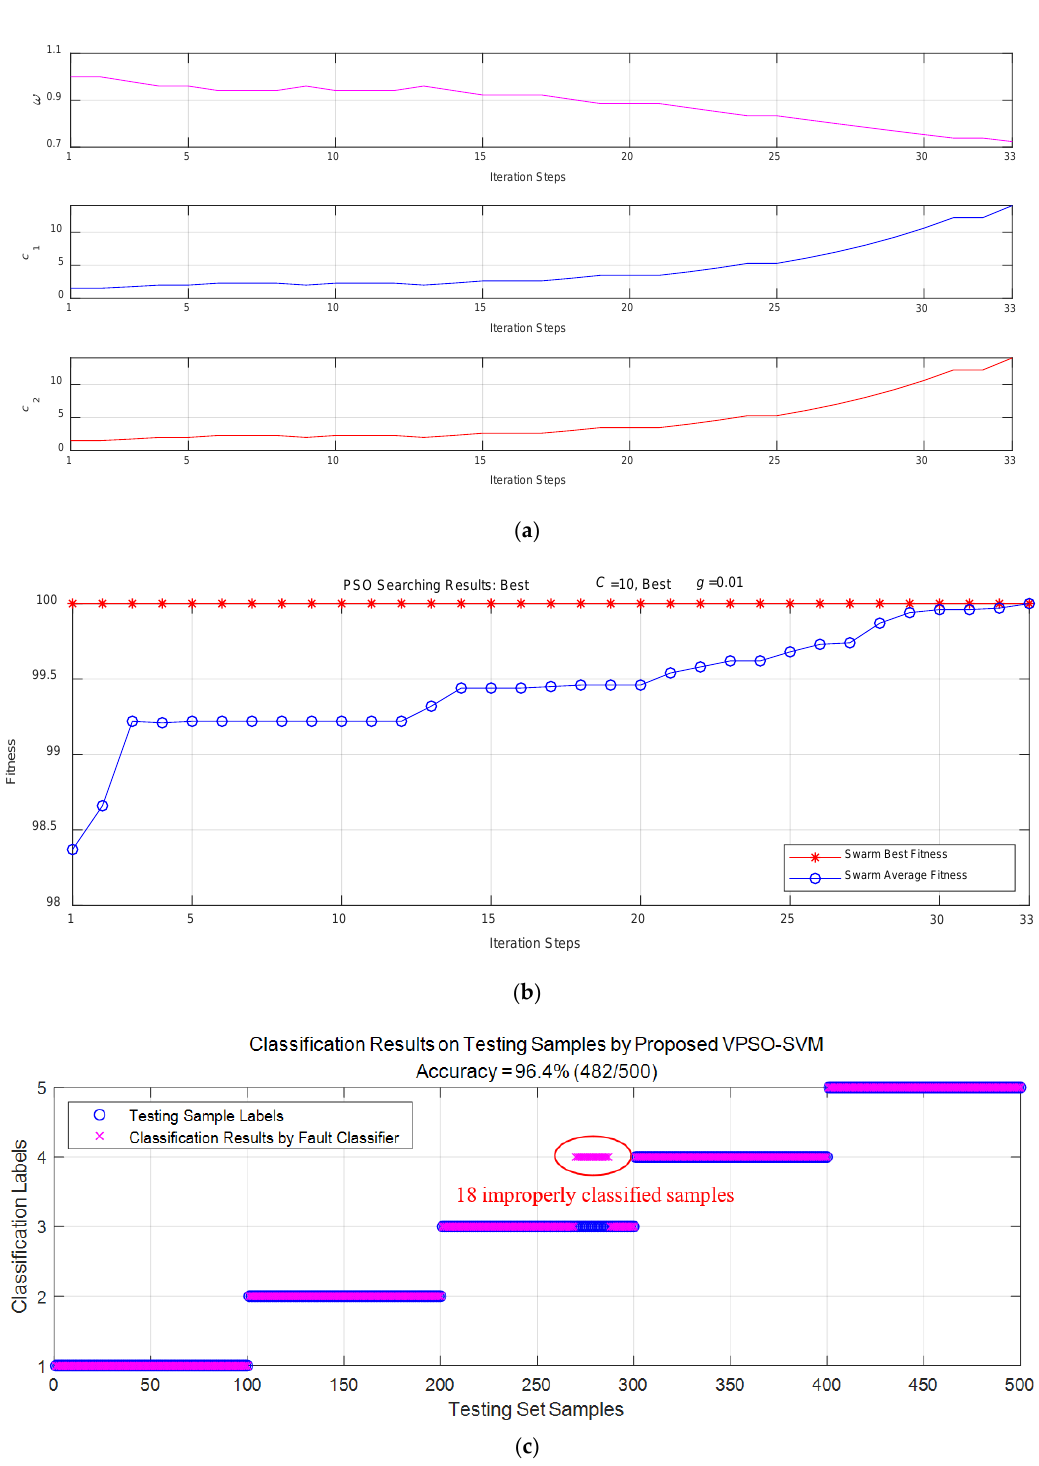
Figure 20. Fault classification results on testing set by VPSO-SVM with SVM parameters C = 10 and g = 0.01 optimized by CPSO. ( a ) Variation curves of c 1 , c 2 and ω in PSO along with iterations. ( b ) Swarm average fitness evolving process along iterations (33 iteration steps to converge with variable c 1 , c 2 and ω in PSO). ( c ) Fault classification results of VPSO-SVM with classification accuracy = 96.4%.